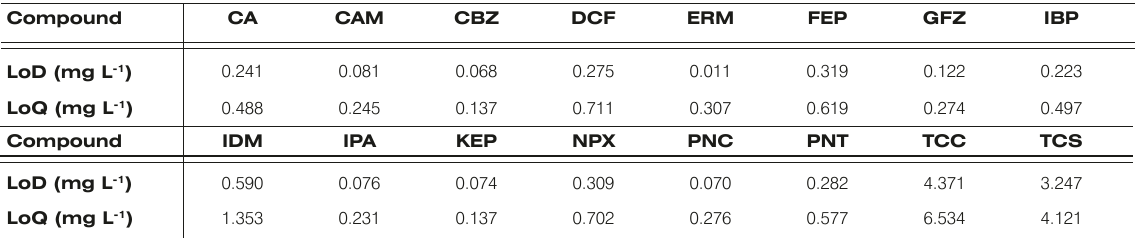
Table 2. Limit of detection (LoD) and limit of quantitation (LoQ) values of the PhCs in ultrapure water for LC-MS/MS analysis. Compound